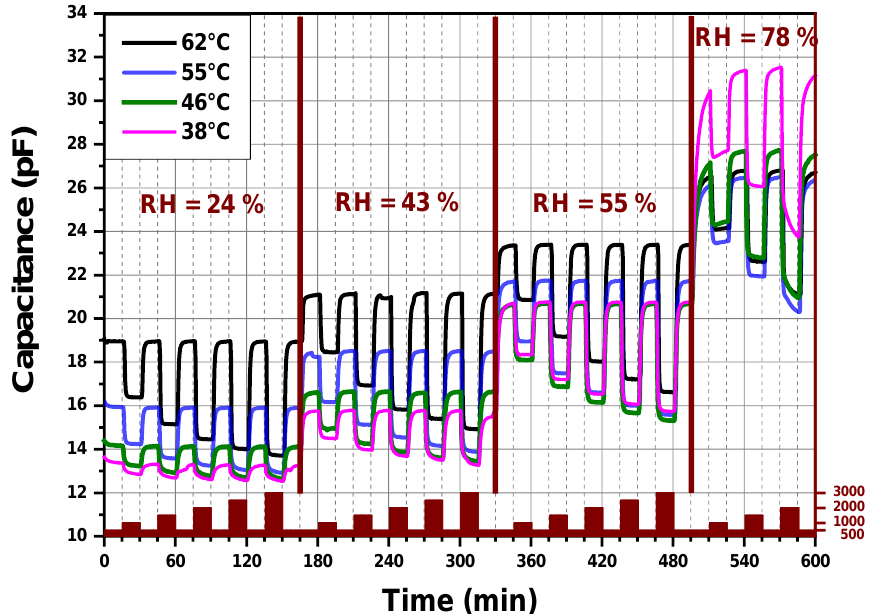
Figure 5. Capacitance versus time for a PEI@silica ( 100 nm )-based CO 2 sensor at different operating temperatures and different relative humidity levels.